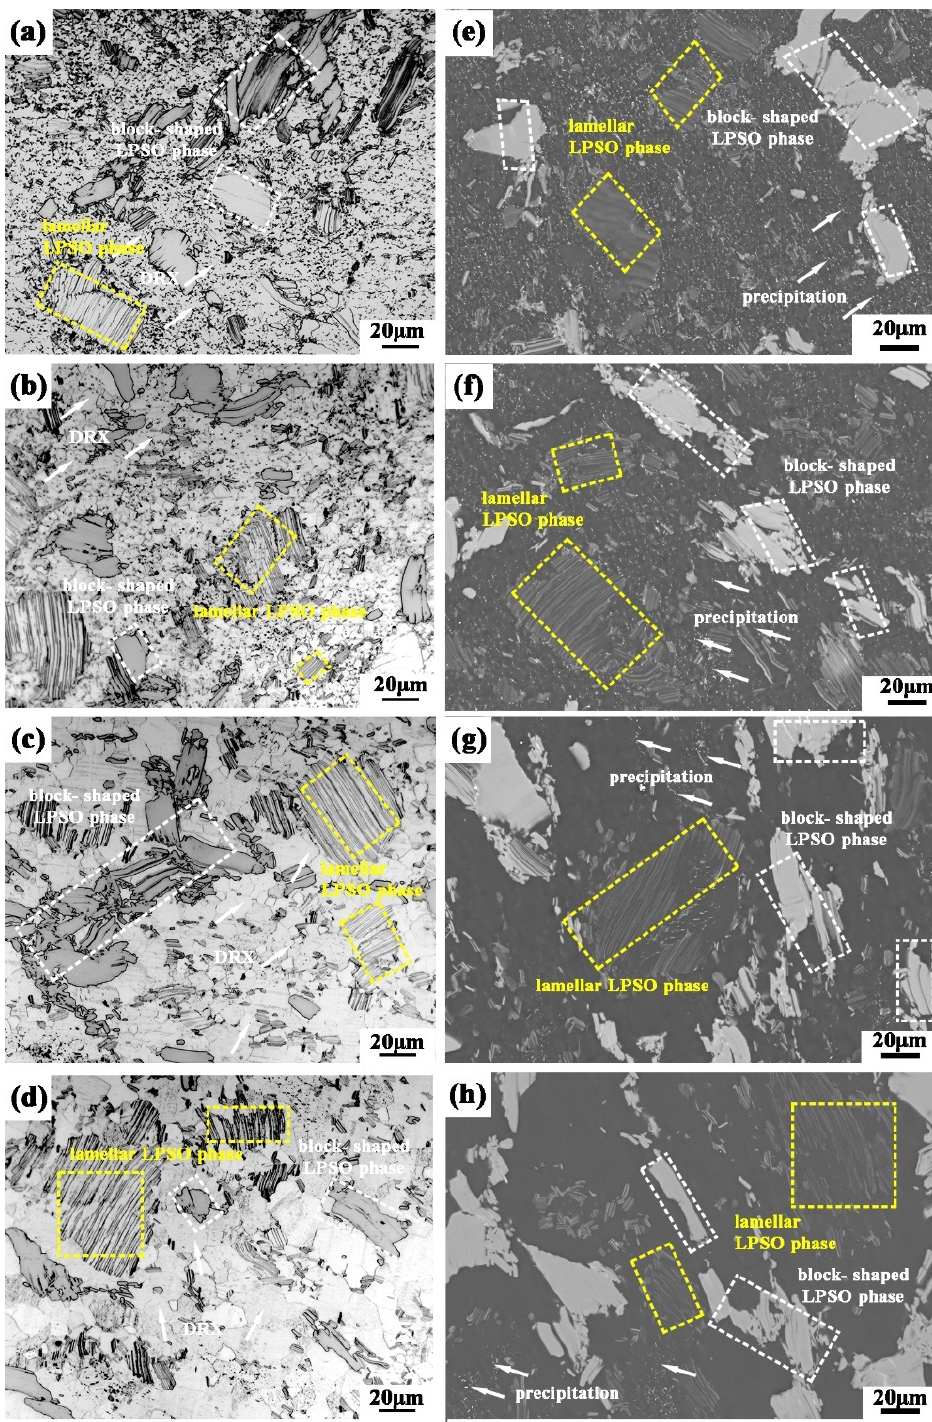
Figure 8. Microstructure evolution of deformed samples at a strain rate 0.001 s − 1 and at temperatures 653 K, 683 K, 713 K, and, 743 K, respectively: ( a – d ) OM maps; ( e – h ) SEM maps (white and yellow square frame showed lamellar LPSO phase and block-shaped LPSO phase, respectively).